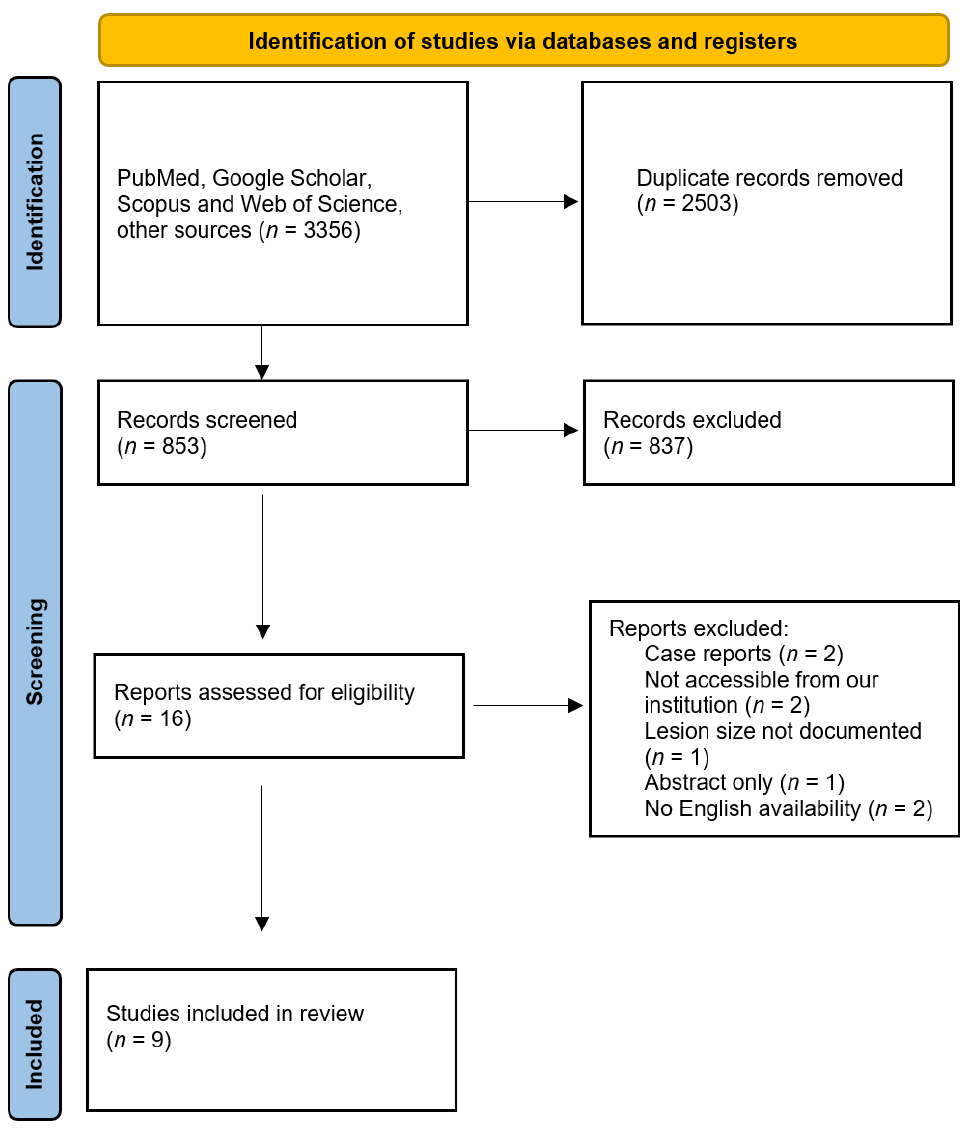
Figure 1. PRISMA flowchart showing inclusion and exclusion of the